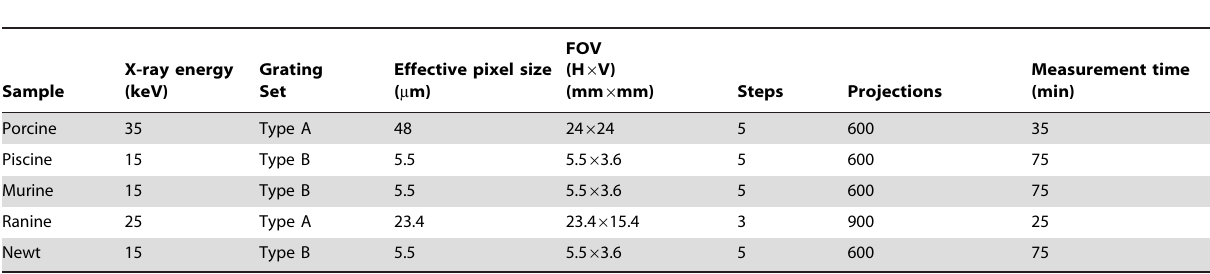
Table 3. Parameters used in the measurement of refractive index.